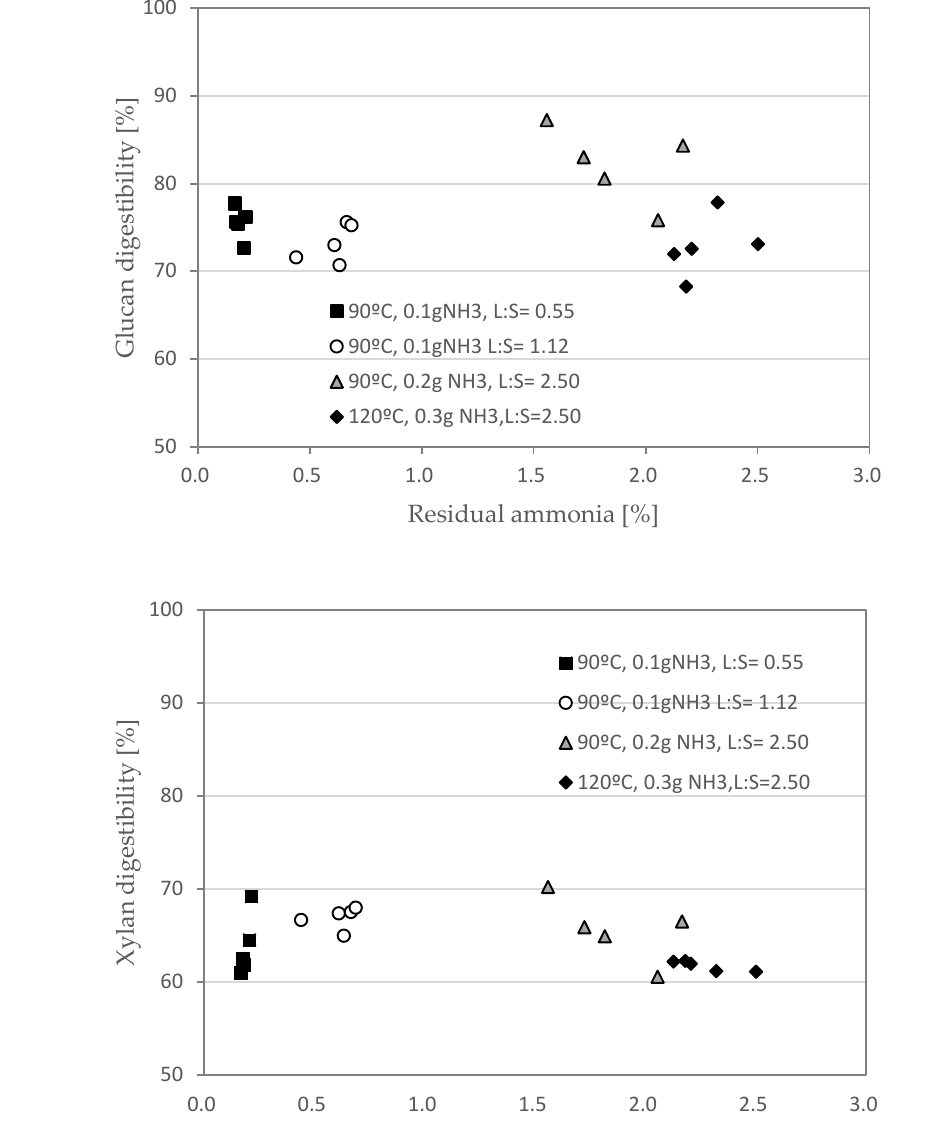
Figure 5. Effect of L/S ratio on enzymatic digestibility of corn stover. ( a ) 0.1g NH 3 loading, ( b ) 0.2g NH 3 loading, ( c ) 0.3g NH 3 loading ELLA treatment conditions: L/S = 0.55, 1.12, 2.5; 0.1 – 0.3 g-NH 3 /g-biomass, 90 – 150 °C, 24 – 120 h. Enzymatic hydrolysis conditions: CTech2; 15 FPU/g-glucan loading; 50 °C; 150 rpm; hydrolysis time, 72 h.